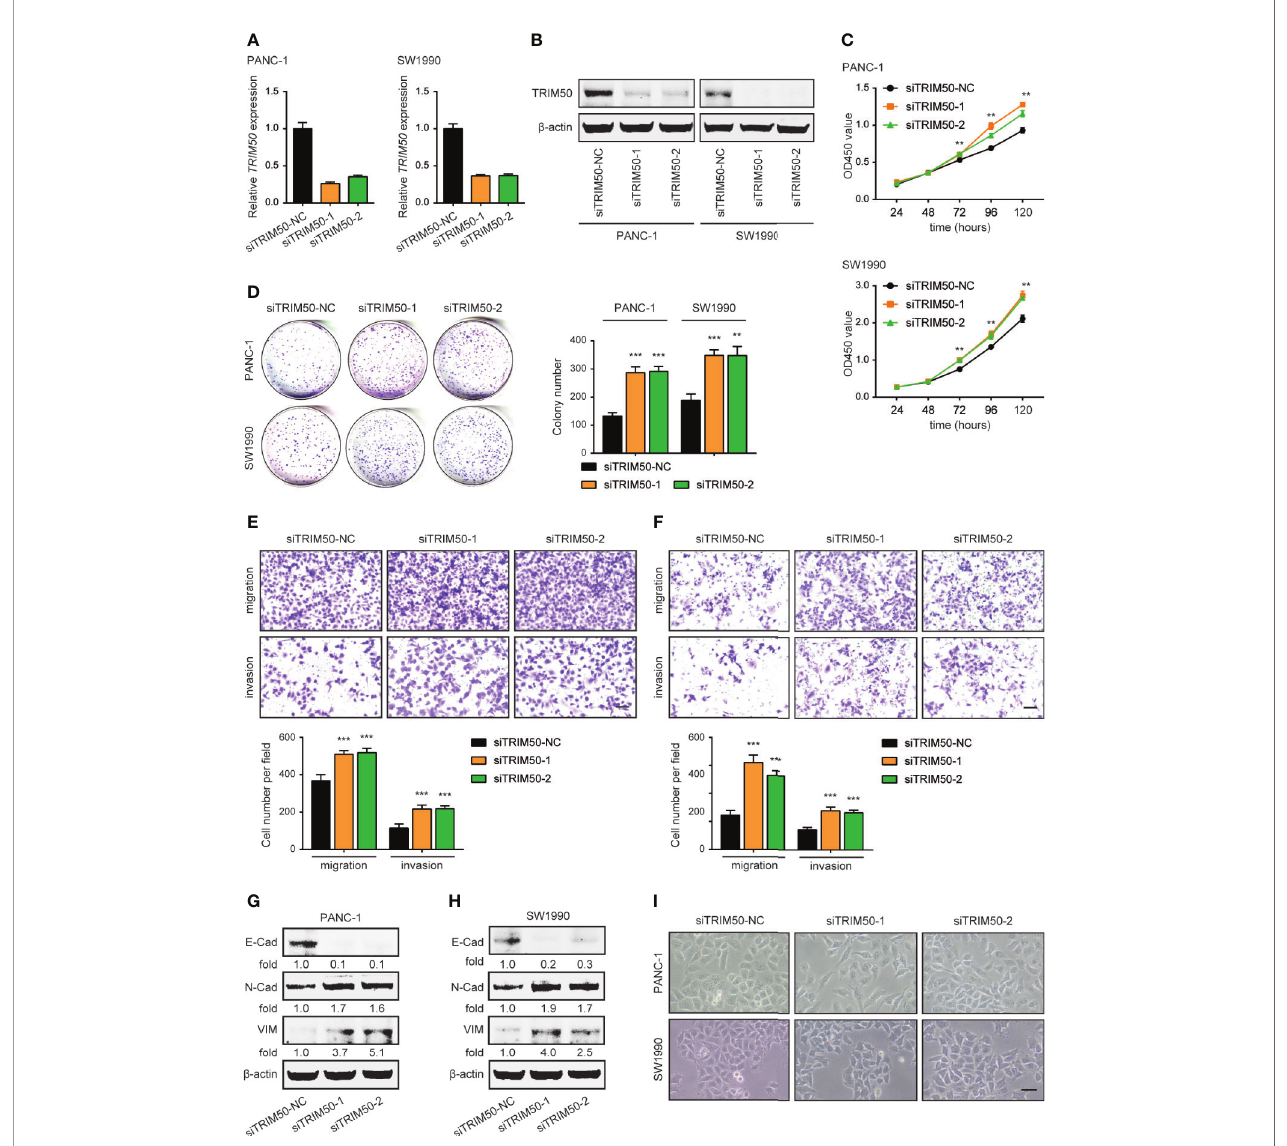
FIGURE 4 | Depletion of TRIM50 promotes cell proliferation, migration, and invasion and induces EMT in pancreatic cancer. (A, B) The ef fi ciency of TRIM50 depletion con fi rmed by qRT-PCR (A) and western blotting (B) . (C, D) The effect of TRIM50 depletion on cell proliferation revealed by CCK-8 (C) and colony formation (D) assays. (E, F) The effect of TRIM50 depletion on cell migration and invasion of PANC-1 (E) and SW1990 (F) cells revealed by Transwell assays. Scale bar: 50 m m. (G, H) Western blotting con fi rming the decreased expression of E-Cadherin (E-Cad) and increased expression of N-Cadherin (N-Cad) and Vimentin (VIM) following TRIM50 depletion in PANC-1 (G) and SW1990 (H) cells. (I) PANC-1 and SW1990 cells transfected with TRIM50 or control siRNAs were photographed. Scale bar: 50 m m. ** P < 0.01 and *** P <